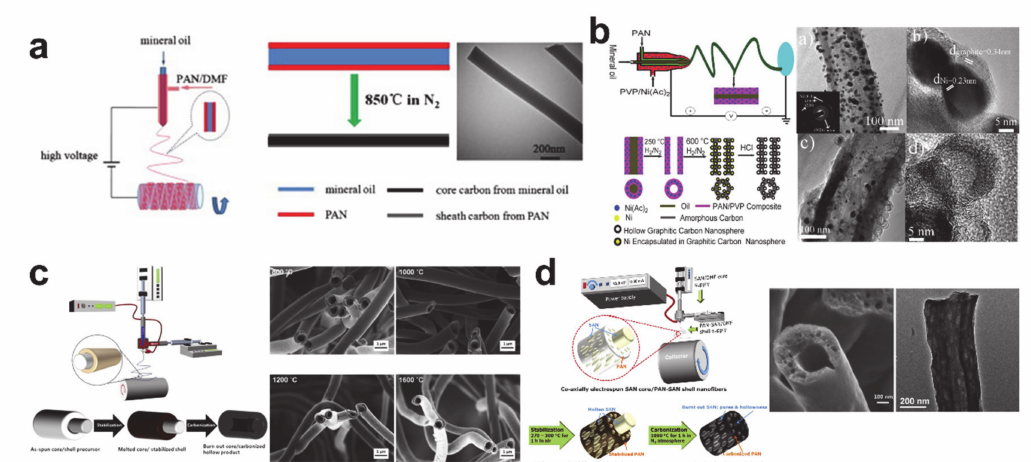
Figure 5. Coaxially electrospun carbon nanofiber anode materials. Schematic processing